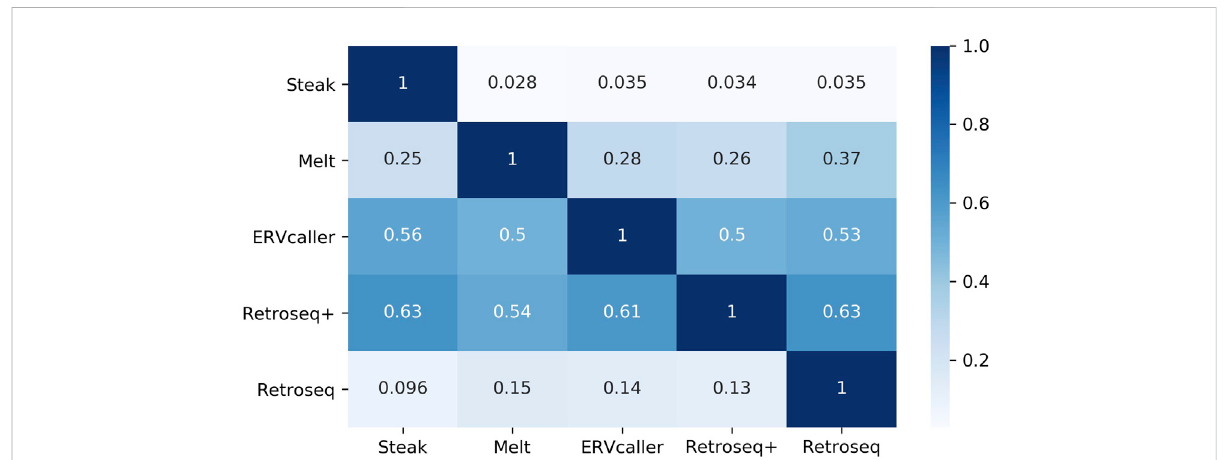
FIGURE 5 Heatmapreportingtheproportionofinsertionsfoundbytoolsontherowsthatwerealsofoundbythetoolsonthecolumns.E.g.theproportion in (Steak, ERVcaller) represents the proportion of Steak calls that were also called by ERVcaller. Therefore, please note that (Steak, ERVcaller) is not equal to (ERVcaller, Steak). Reference HERV-Ks have been fi ltered out.